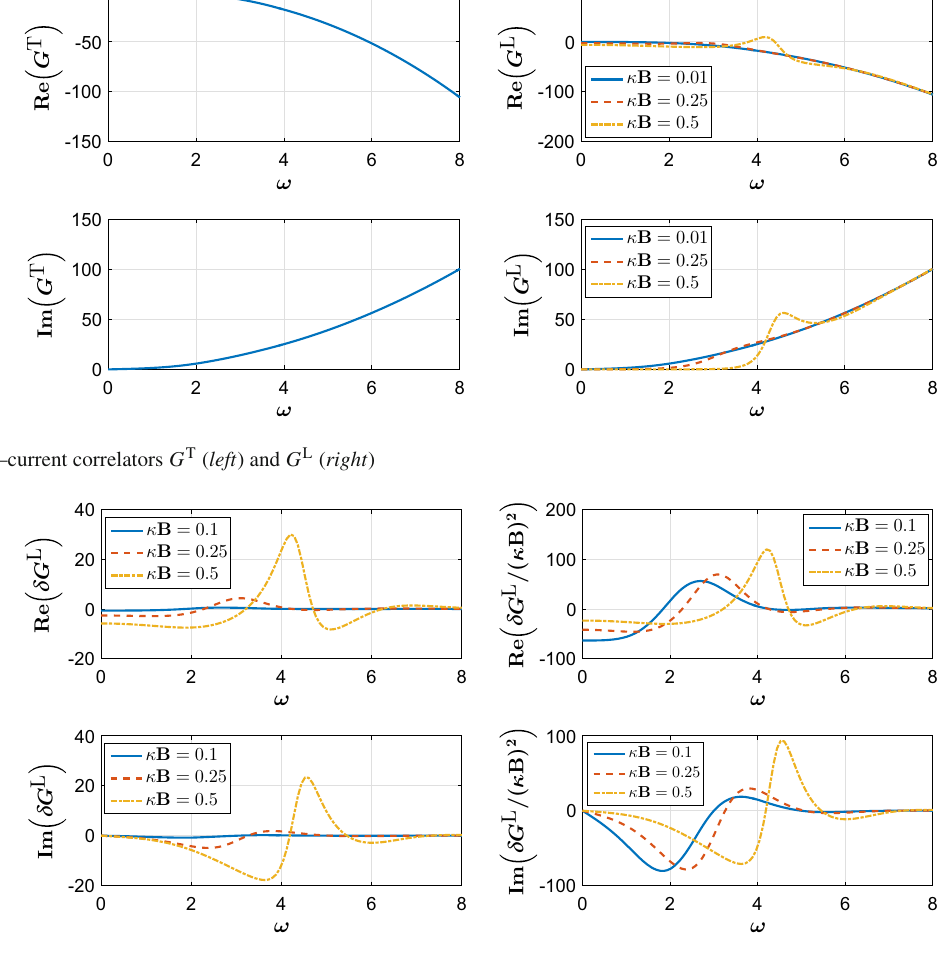
Fig. 5 Anomalous correction to correlator: δ G L ( left ) and δ G L /(κ B ) 2 ( right